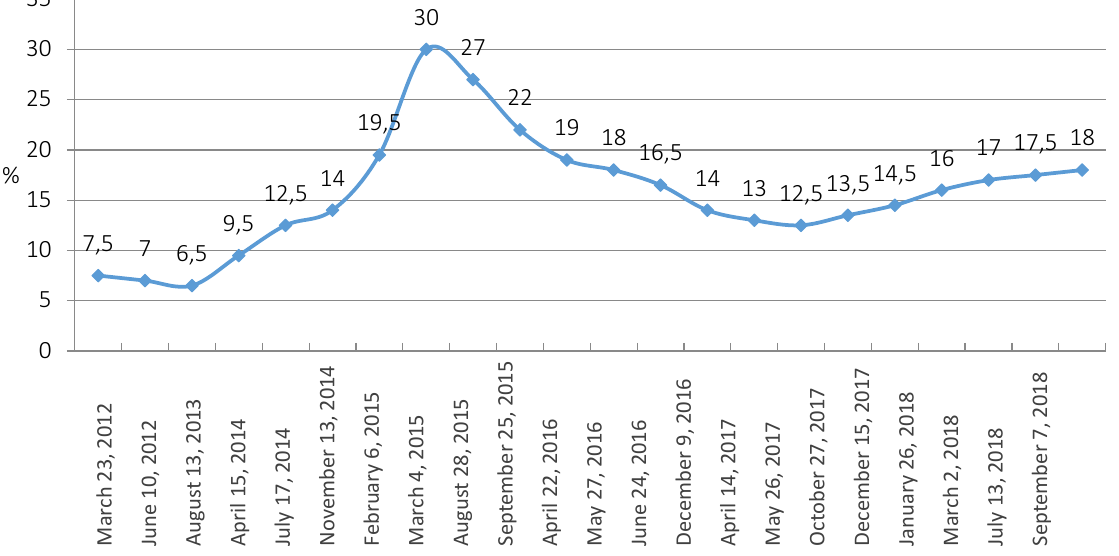
Figure 3. Change of the NBU discount rate in